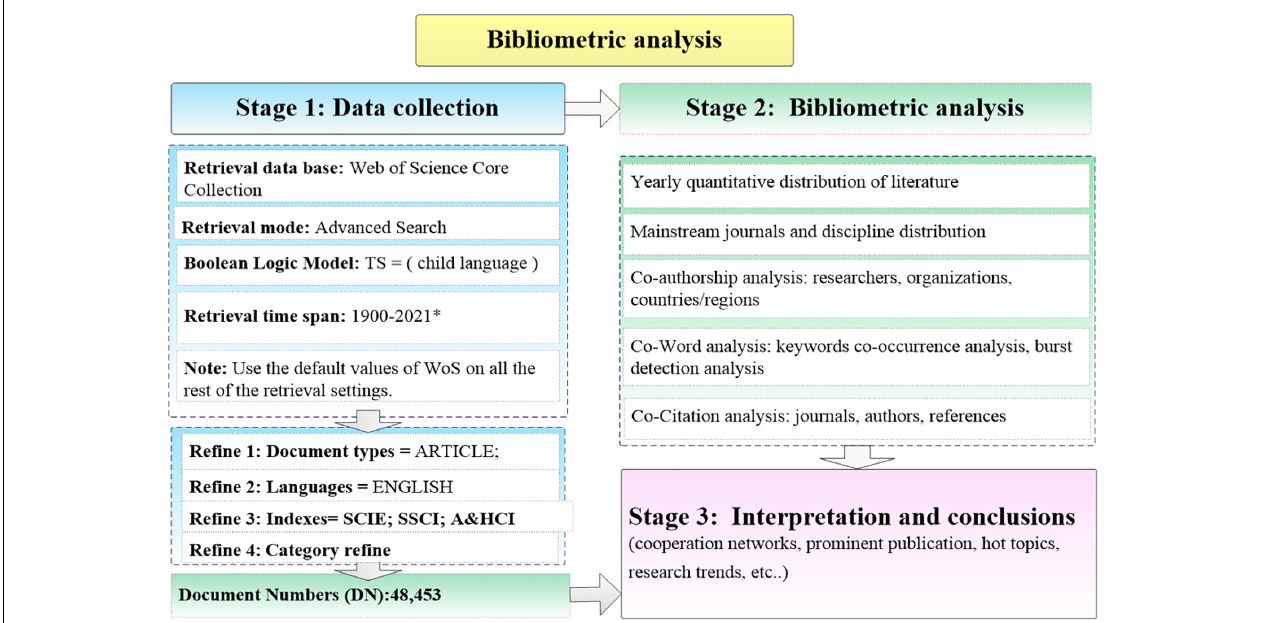
FIGURE 1 | The procedure of the bibliometric analysis on CL. *The database was obtained on 10 April